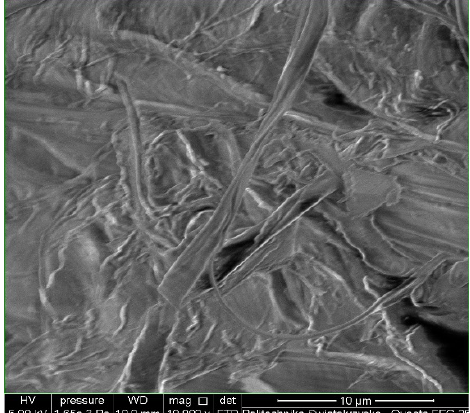
Figure 9. SEM image showing microstructure of a tree used in timber frame construction; magnifica- tion 10 4 ×